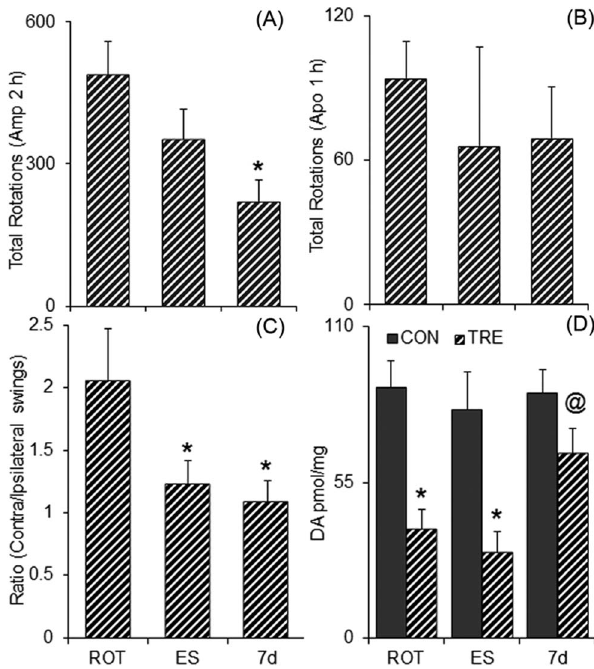
Figure 6. Transplantation-induced functional recovery. Bar graphs in (A) and (B) depict the number of unilateral rotations in hemiparkinsonian rats infused with vehicle only without any cells (ROT), or transplanted with 5 6 10 5 embryonic stem cells, undifferentiated (ES) or 7 days differentiated cells (7 d) in the striatum, and treated with amphetamine (Amp) or apomorphine (Apo) respectively on 14th day or